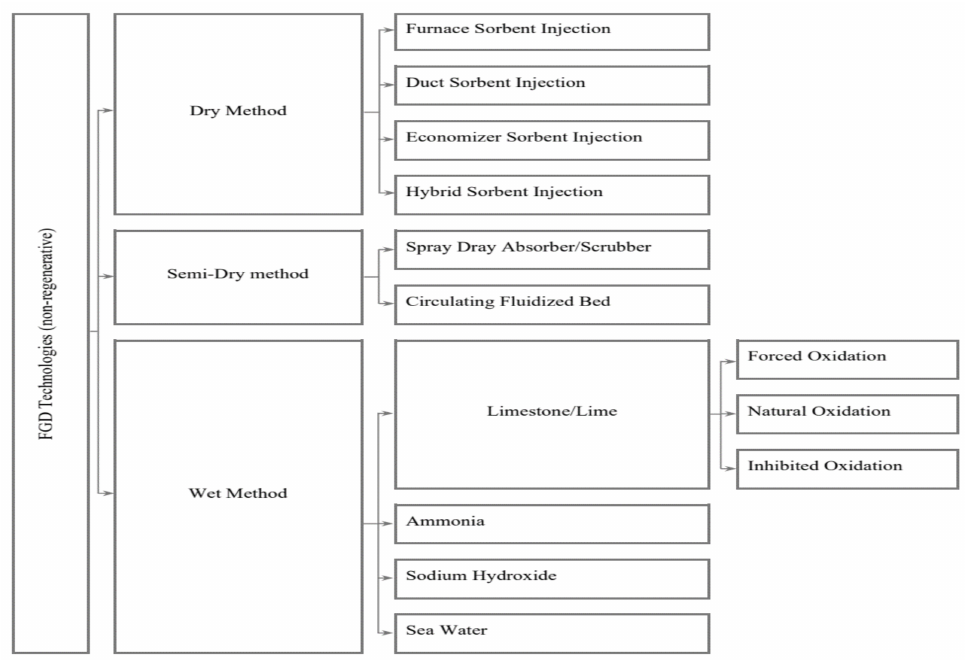
Figure 1. Non-regenerative flue gas desulphurization technologies